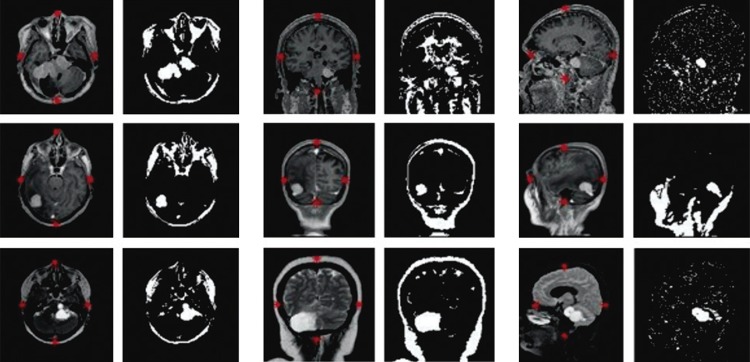
Resultado das etapas de pré-processamento para pacientes distintos da base privada